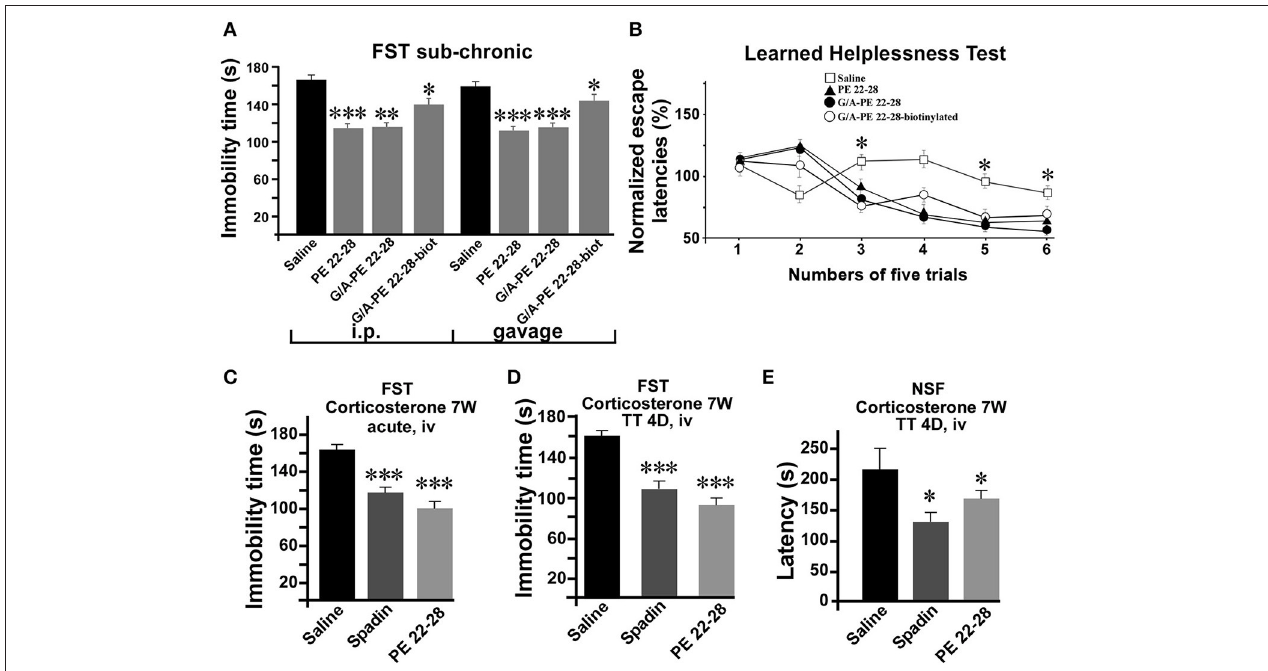
FIGURE 5 | Behavior of spadin-analogs in mouse model of depression. (A) FST performed after a sub-chronic (4 days) treatment (3.0–4.0 µ g/kg) with each spadin-analog or the 0.9% NaCl saline solution. Treatments were administered either by ip injection (100 µ g/kg) or by gavage (1.0mg/kg). (B) The Learned Helplessness test performed with each spadin-analog (3.0–4.0 µ g/kg). 30 trials were divided in 6 pools of five trials. * p < 0.05. (C,D) Corticosterone-induced model of depression. PE 22-28 was used as the representative peptide for spadin-analogs for comparing the effects of spadin-analogs with those of spadin in this chemically-induced mouse model. FST performed after acute (30 min after injection, (C) or sub-chronic (4 days treatment, D ) ip injections of spadin (100 µ g/kg) or PE 22-28 (3.0 µ g/kg). Sub-chronic treatments administered at the same doses were also used before the NSF (E) . * p < 0.05, ** p < 0.01, *** p <